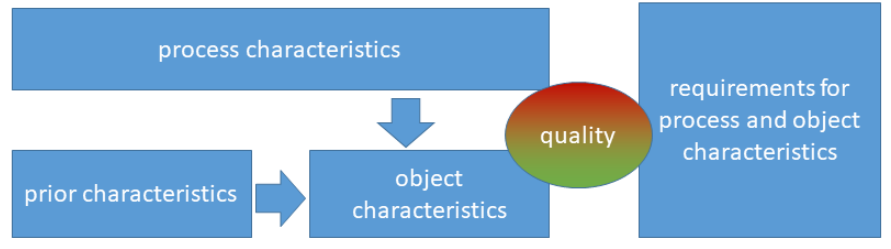
Figure 3. Interaction of the different characteristic types and the requirement to determine